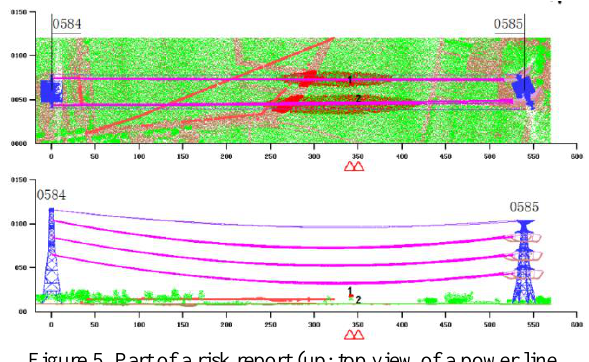
Figure 5. Part of a risk report (up: top view of a power line corridor; down: front view)